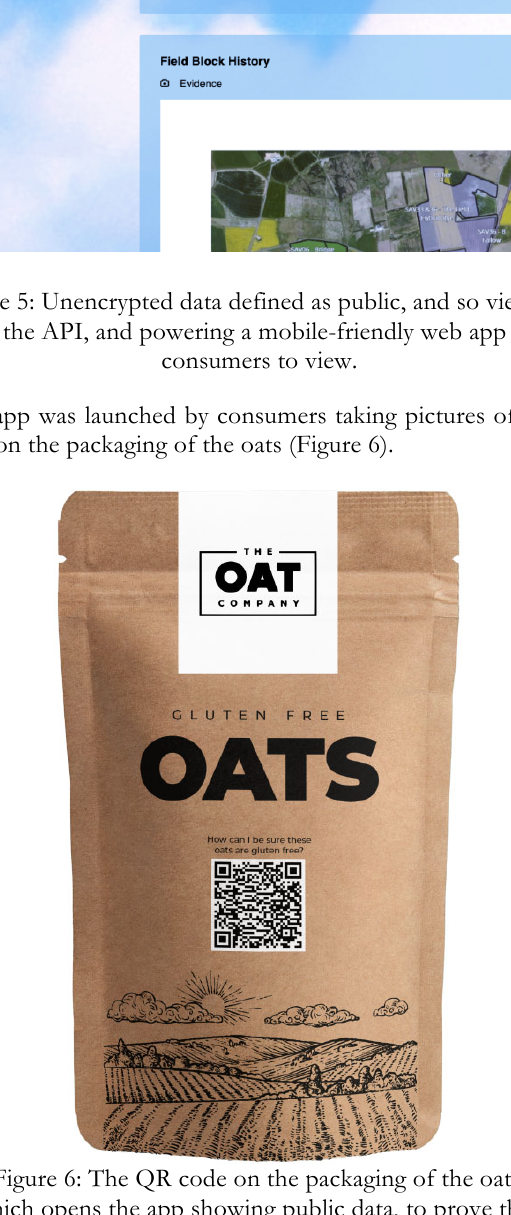
Figure 3: Granular permissioning of each piece of data in SICCAR (see http://wallet.services).